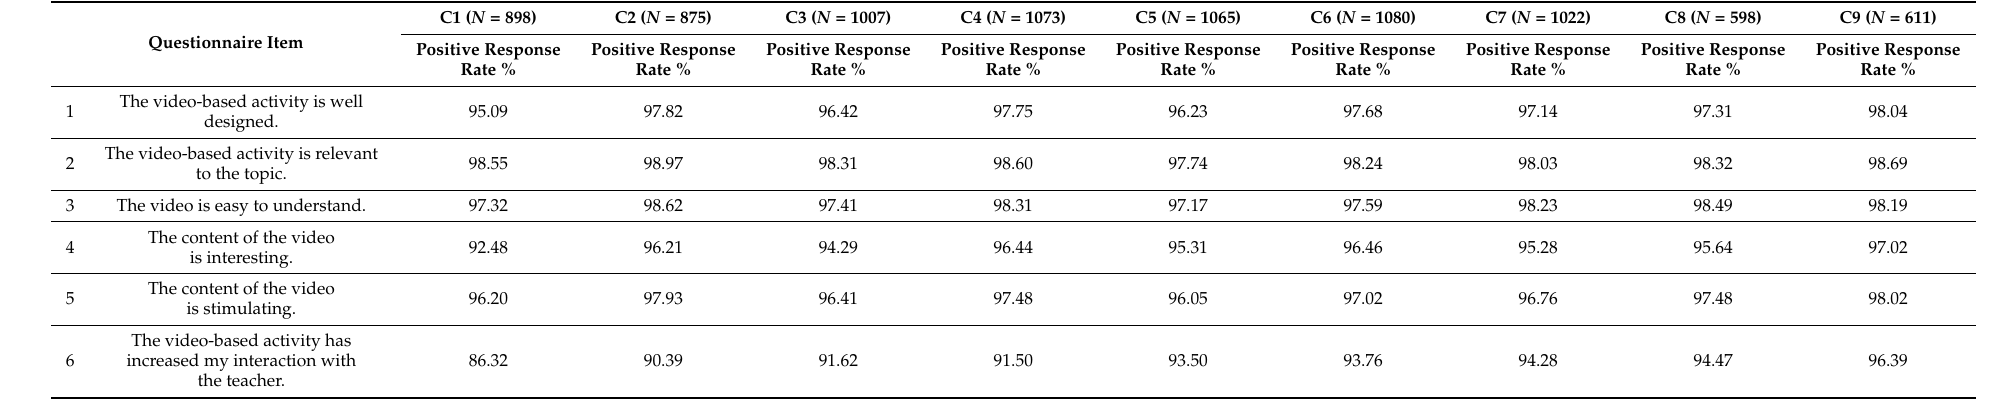
Table 6. Positive Responses Rates of Post-Lecture Video Evaluation for the Nine Case-based Videos (Application and